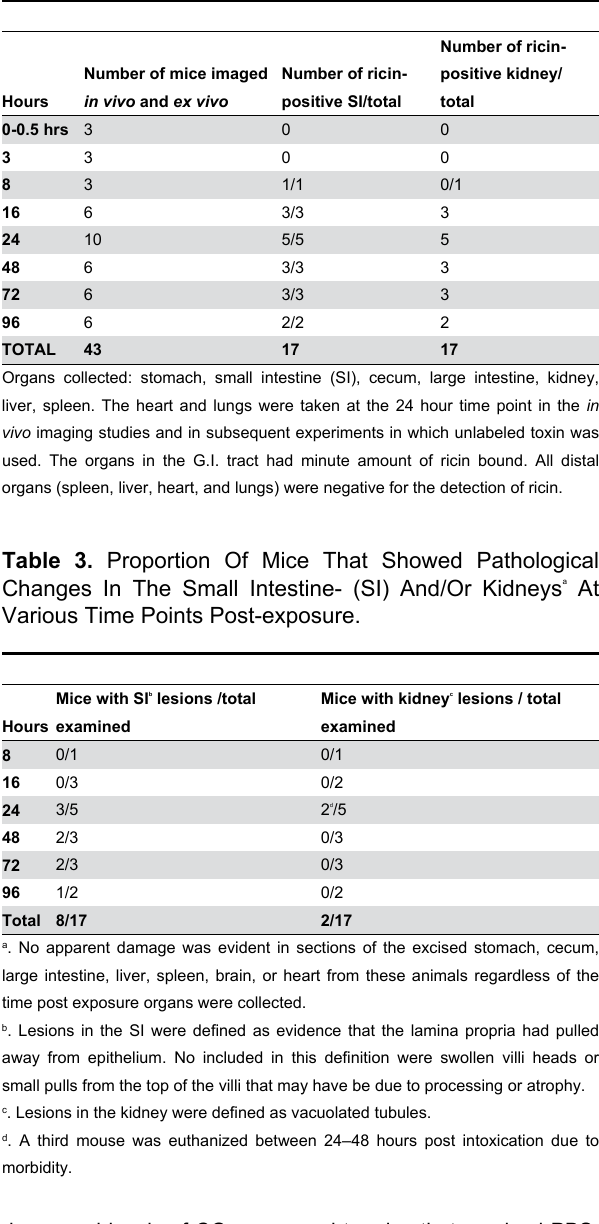
Table 2. Number of Mice, Organs, and Tissue Sites Examined for Ricin in vivo Imaging and Immunofluorescence.